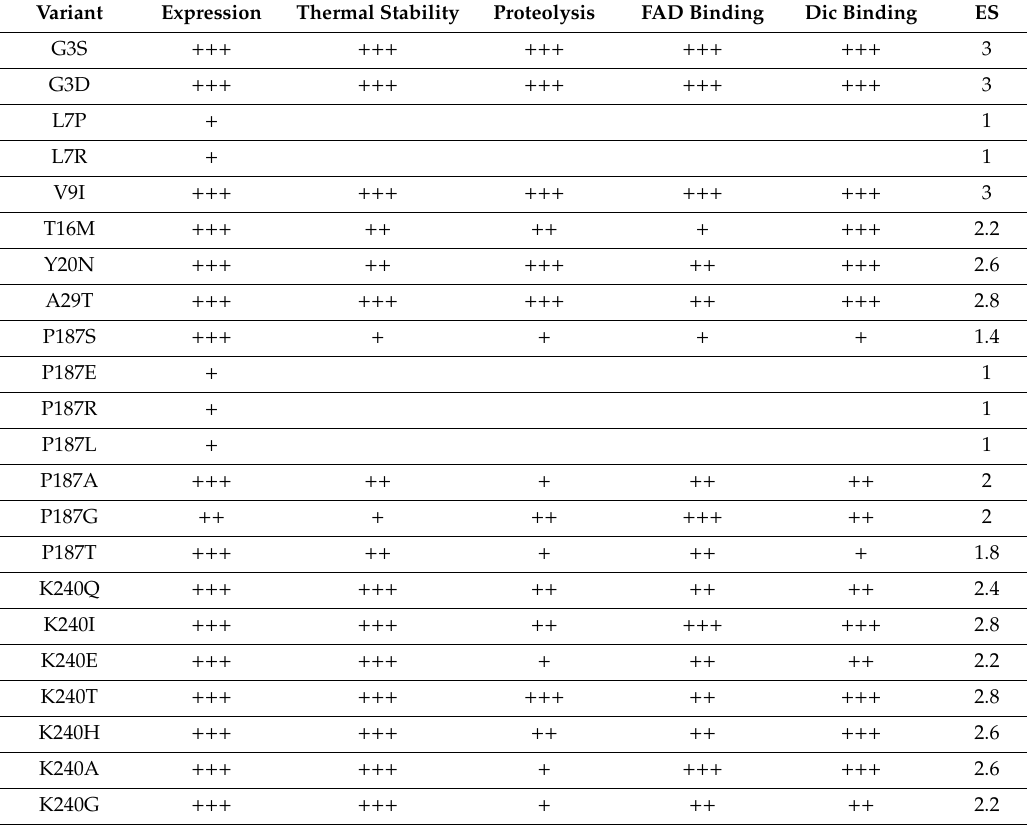
Table 3. Classification of phenotypic consequences due to NQO1 mutations based on experimental data. The experimental scores (ES) are calculated as the average from individual scores determined for each phenotypic trait as follows: Expression: +++ , 50–100% of WT levels; ++ , 20–50% of WT levels; + , < 20% of WT levels; Thermal stability: +++ , within 2 ◦ C of WT T ++ , within 2–5 ◦ C of WT T + , m ; m ; > 5 ◦ C lower than WT T +++ , rate constant within three-fold vs. WT (0.65 kcal · mol − 1 ); ++ m ; Proteolysis: